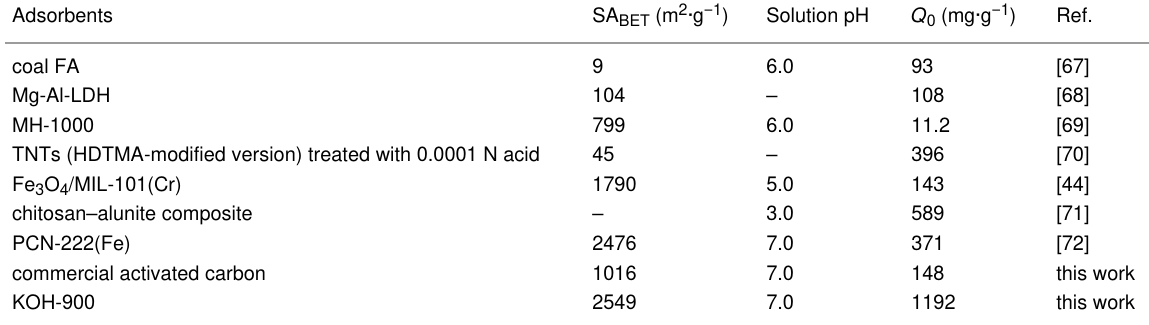
Table 1: Maximum adsorption capacity ( Q 0 ) of some reported adsorbents for the adsorption of AR1 from water.